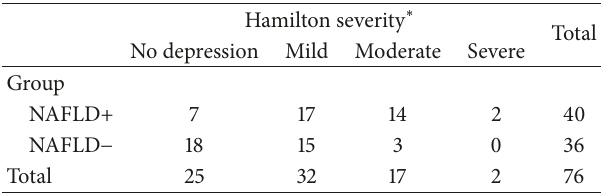
Table 3: Depression grades in observed and control